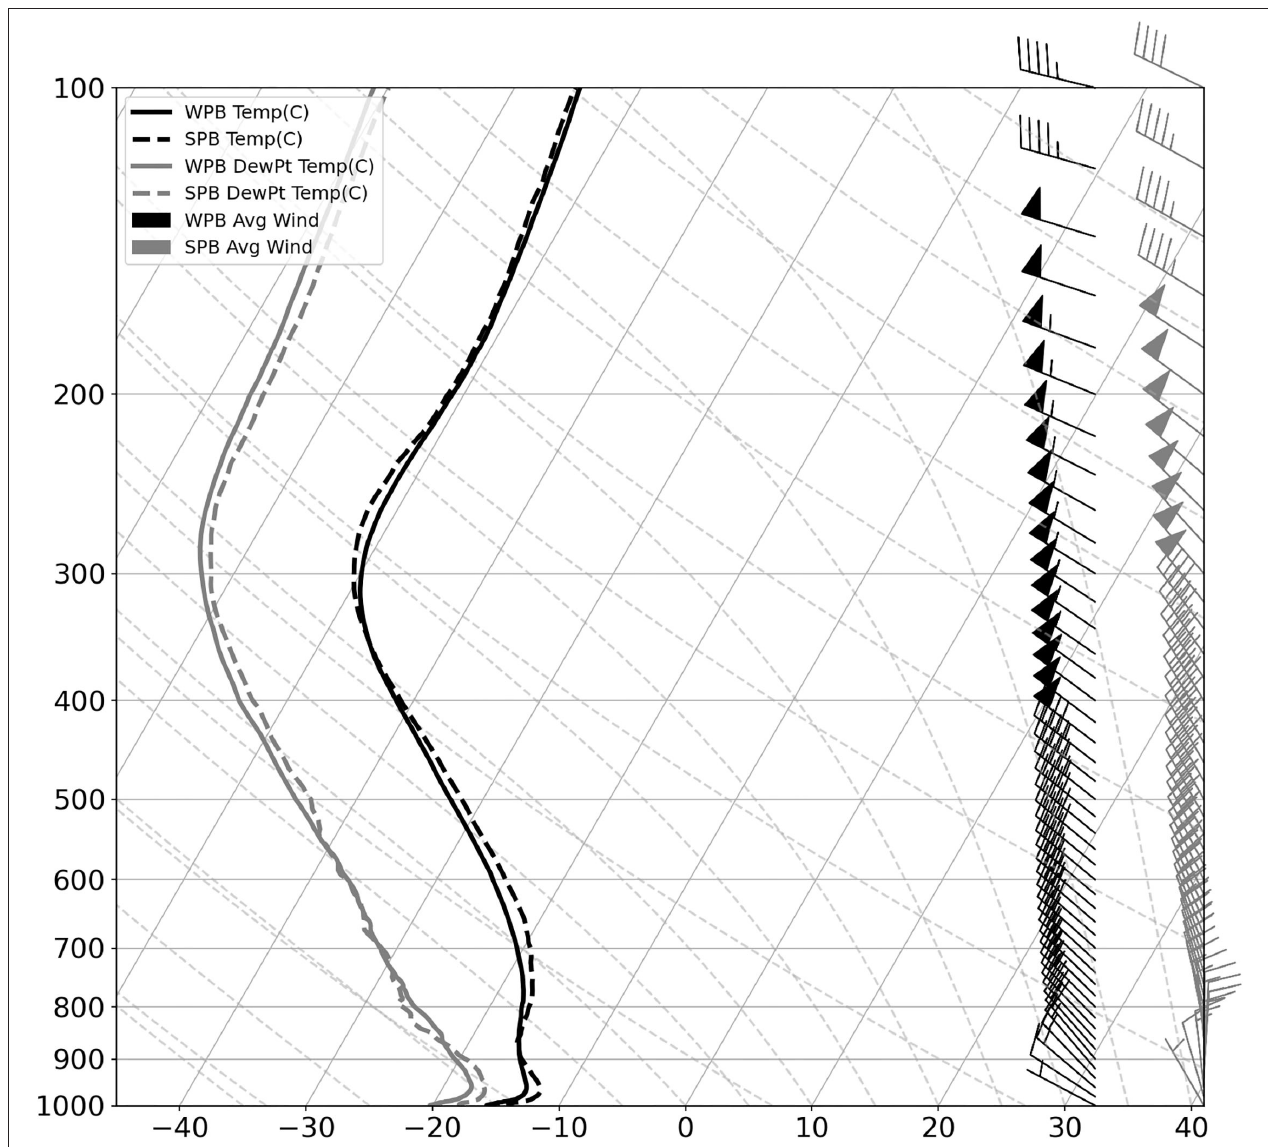
FIGURE 6 | Composite 12 UTC Green Bay, WI, sounding temperature for WPB (solid black) and SPB (dashed black) days. Composite dew point temperature is indicated by gray lines for WPB (solid) and SPB (dashed) days, and the wind profiles for WPB (black) and SPB (gray) days are also provided. Thirteen soundings were